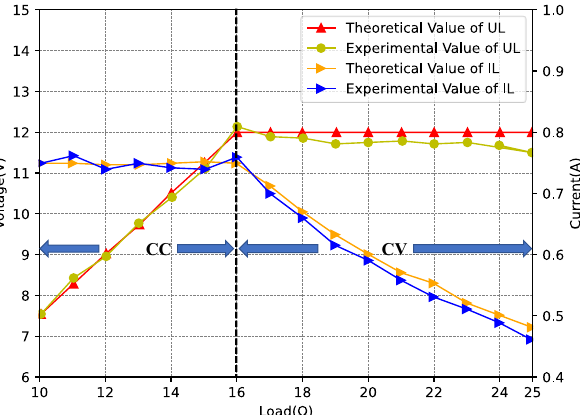
Figure 14. Comparison between experimental results and theoretical values.